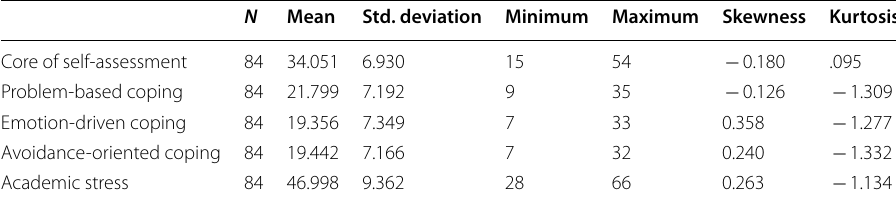
Table 2 Central indicators and dispersion of research variables